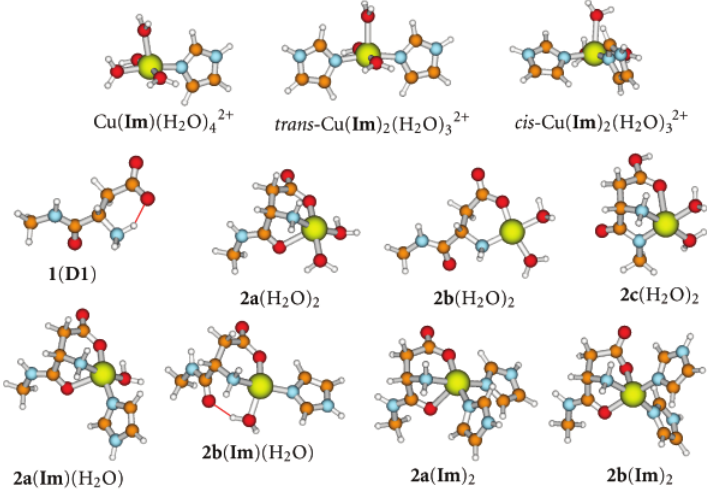
Figure 1: Structures with Cu(II), Asp1, and imidazole Im . Ball colors: Cu: large yellow; C: orange; N: blue; O: red; H: white.